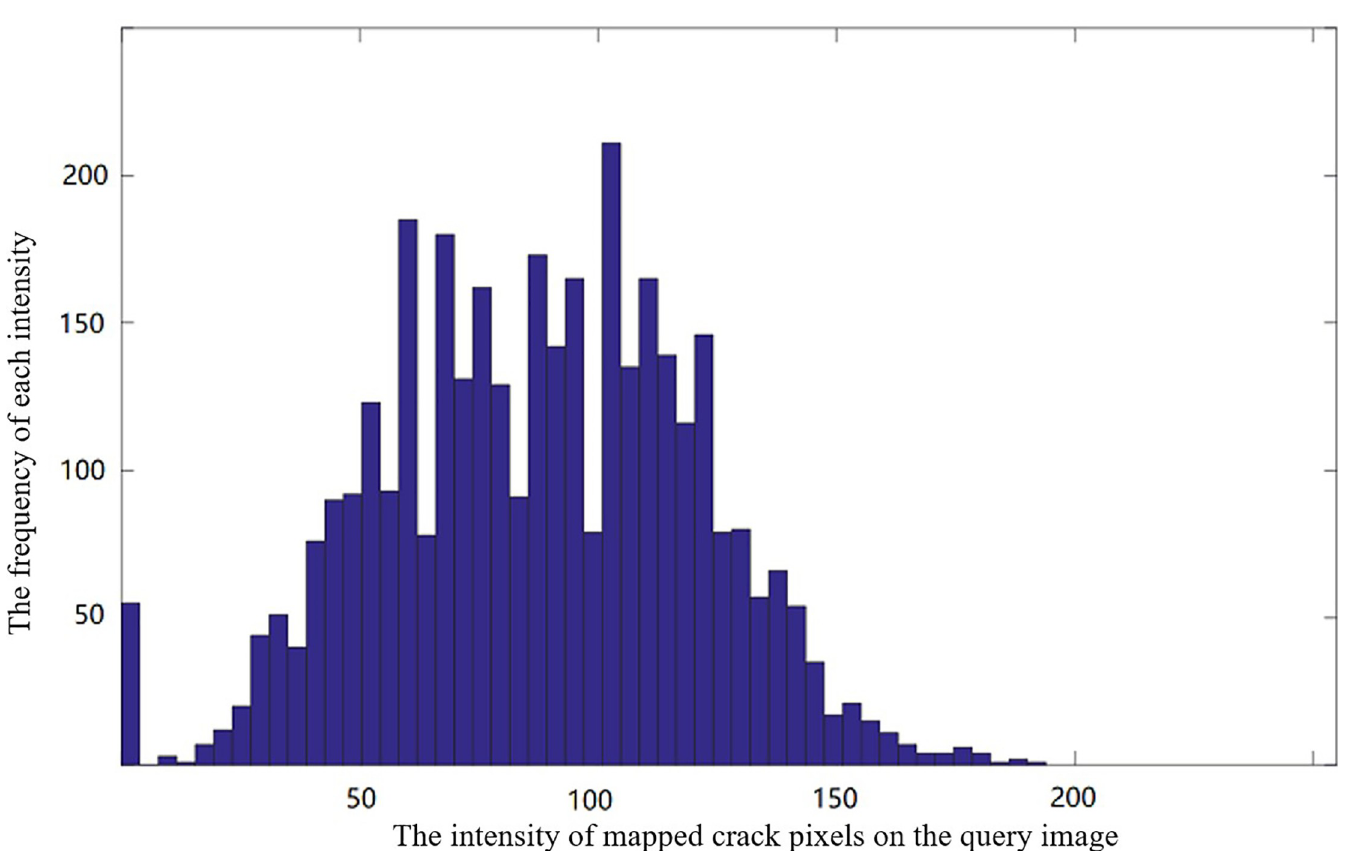
Fig 4. Histogram of pixel intensities from the mapped crack data on the query